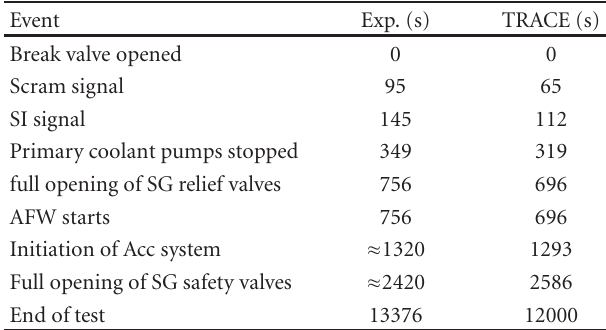
Table 11: Chronology of the main events in Test 5-2